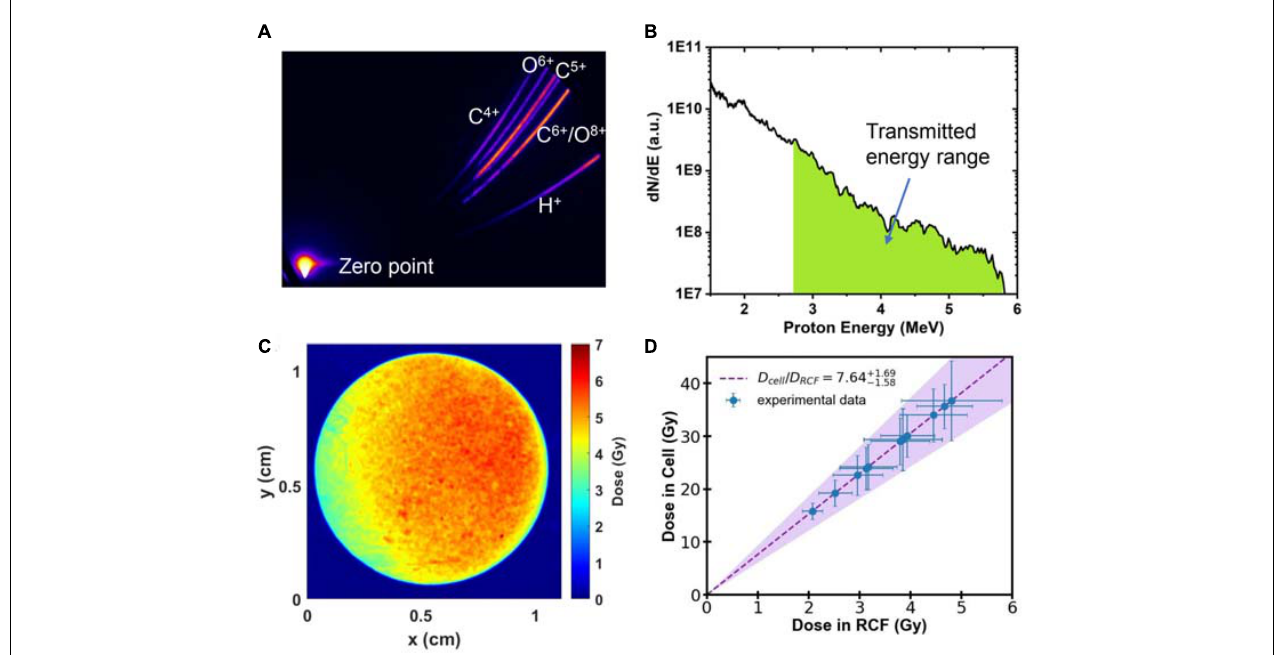
FIGURE 2 | (A) Raw image obtained by the Thomson Parabola Spectrometer. (B) Typical energy spectra of laser-accelerated protons. Protons with energy in the green area can pass through the monolayer cell. (C) Spatial distribution of dose detected by RCF film from a single shot. (D) The dose deposited in the monolayer cell as a function of the measured dose with RCF